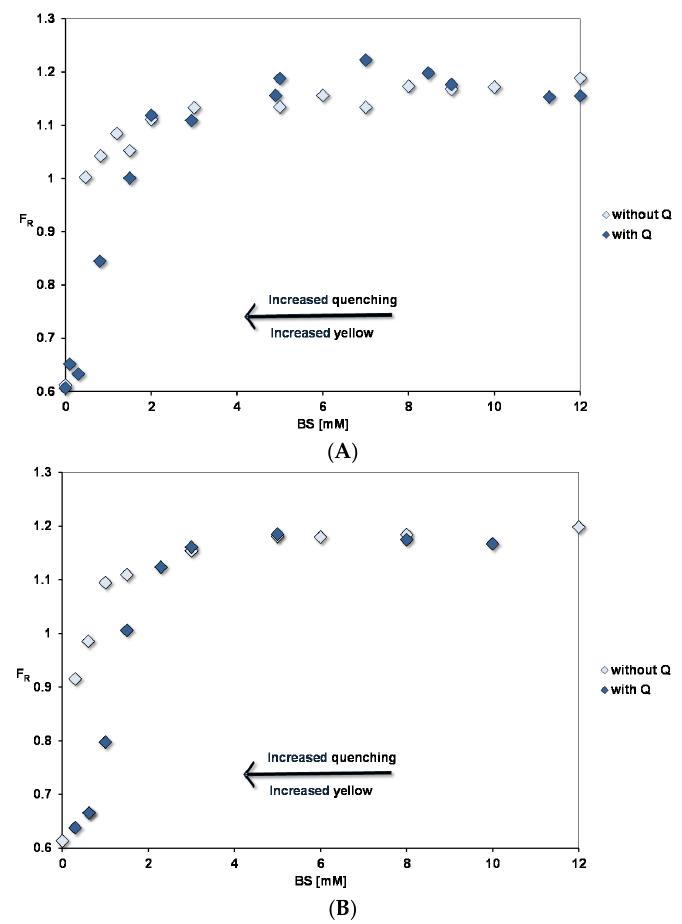
Figure 2 . Pyrene fluorescence in fed state mixed micelles with BS: PC ratio of ( A ) 2:1 and ( B ) 5:1. The OA concentrations relative to the BS concentrations are as in Table 1.